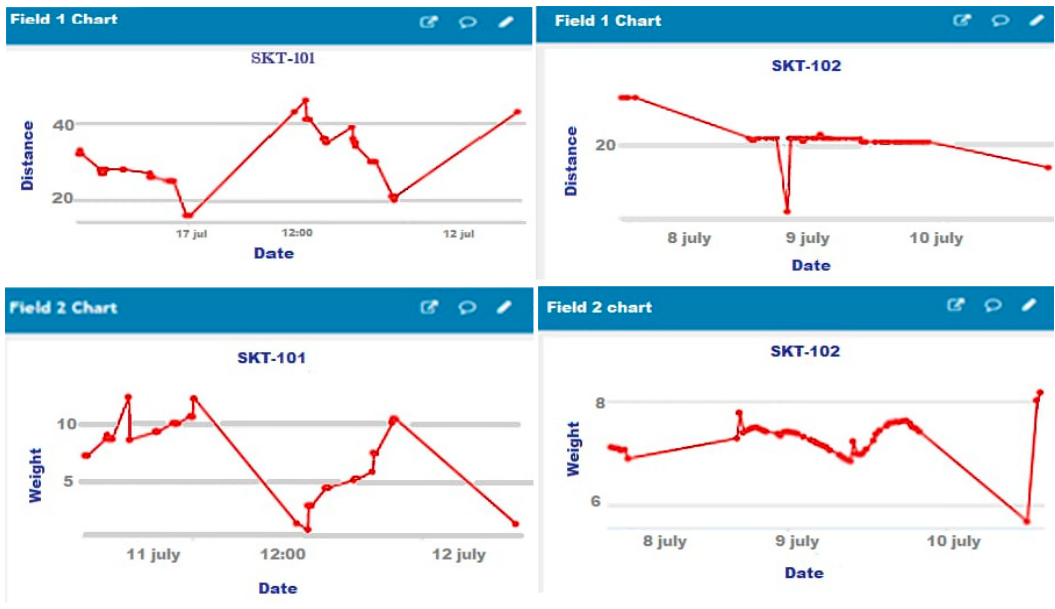
Figure 7. Real-time data of two smart bins.